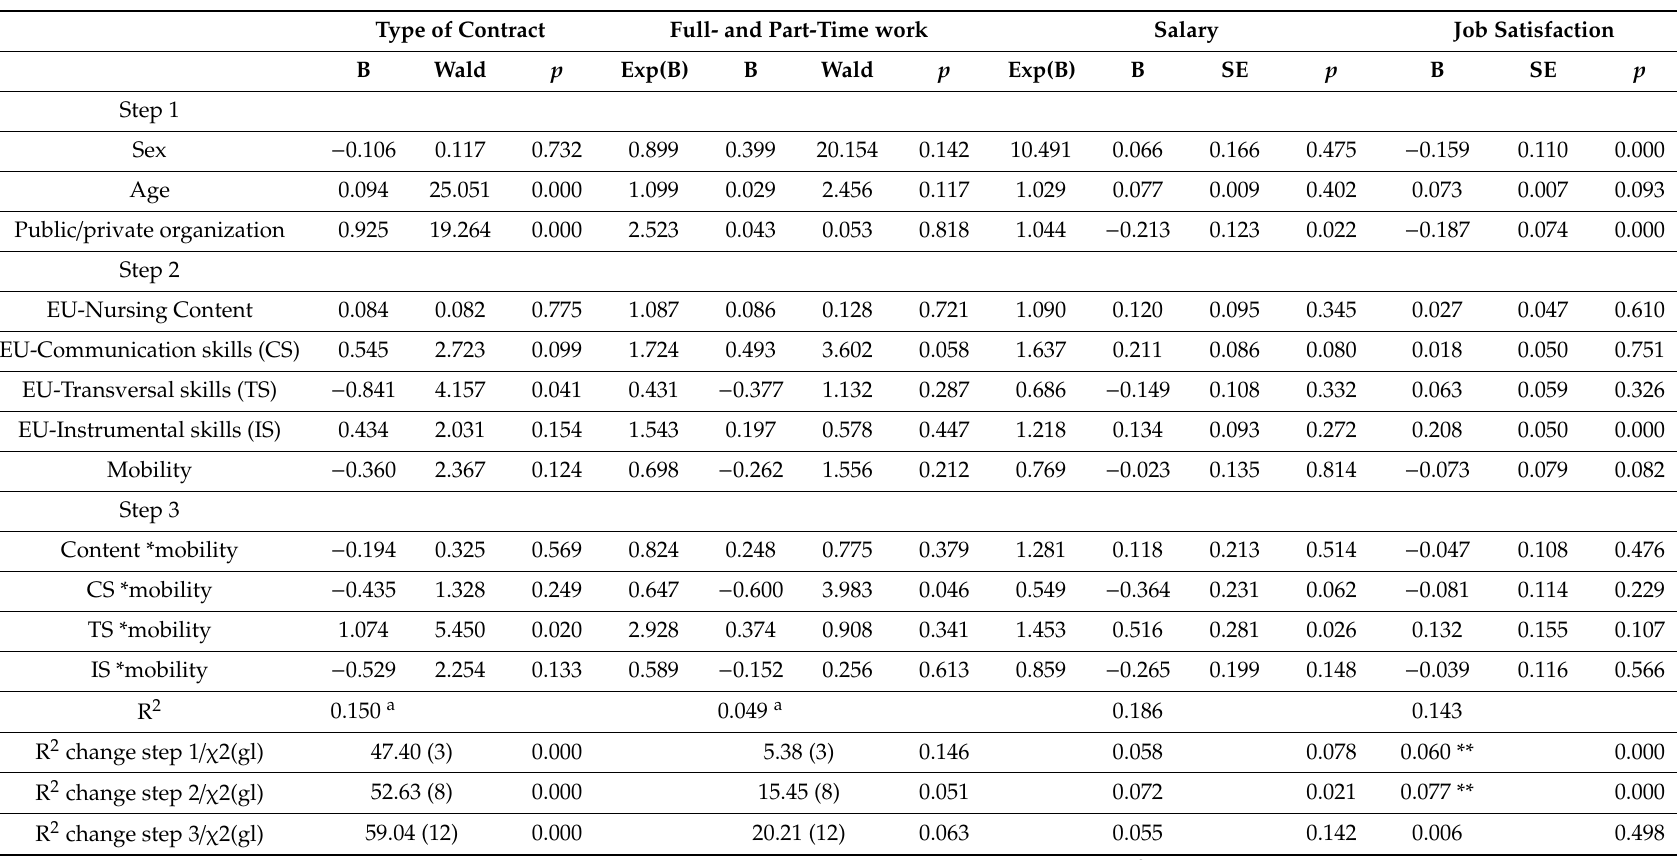
Table 5. Regression analysis for Education Usefulness (EU-) in current job and mobility in predicting salary, job satisfaction, full / part-time, and type of contract. Type of